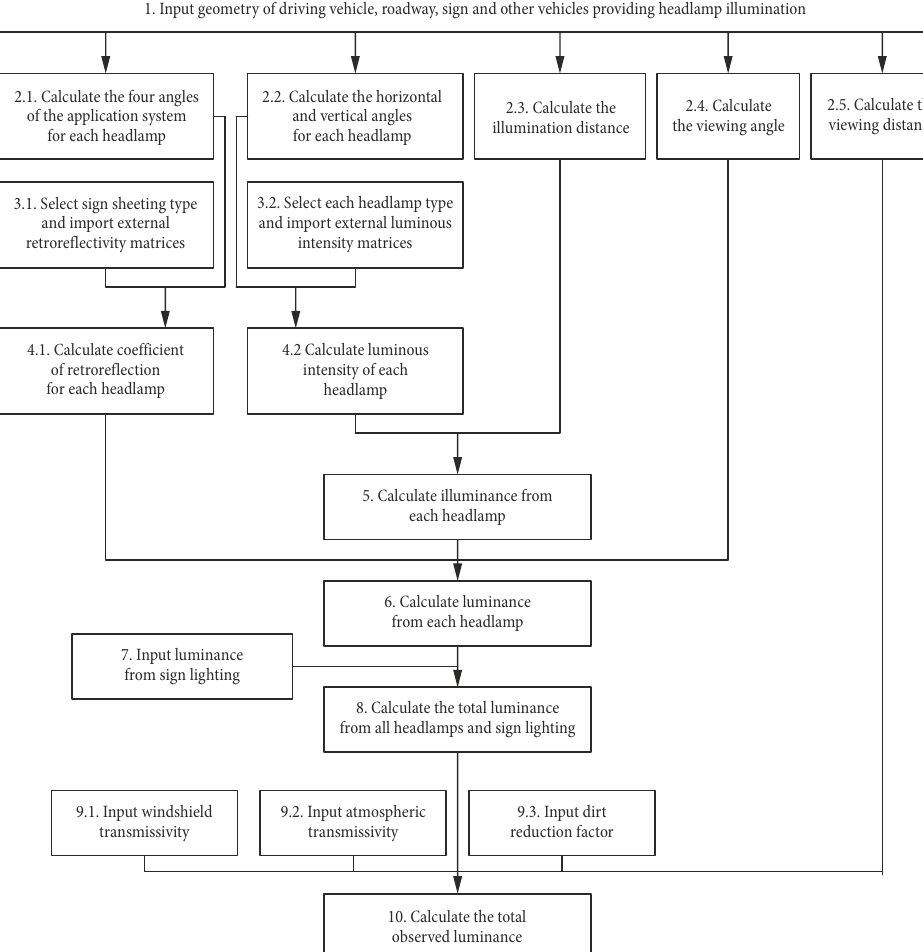
1. Input geometry of driving vehicle, roadway, sign and other vehicles providing headlamp